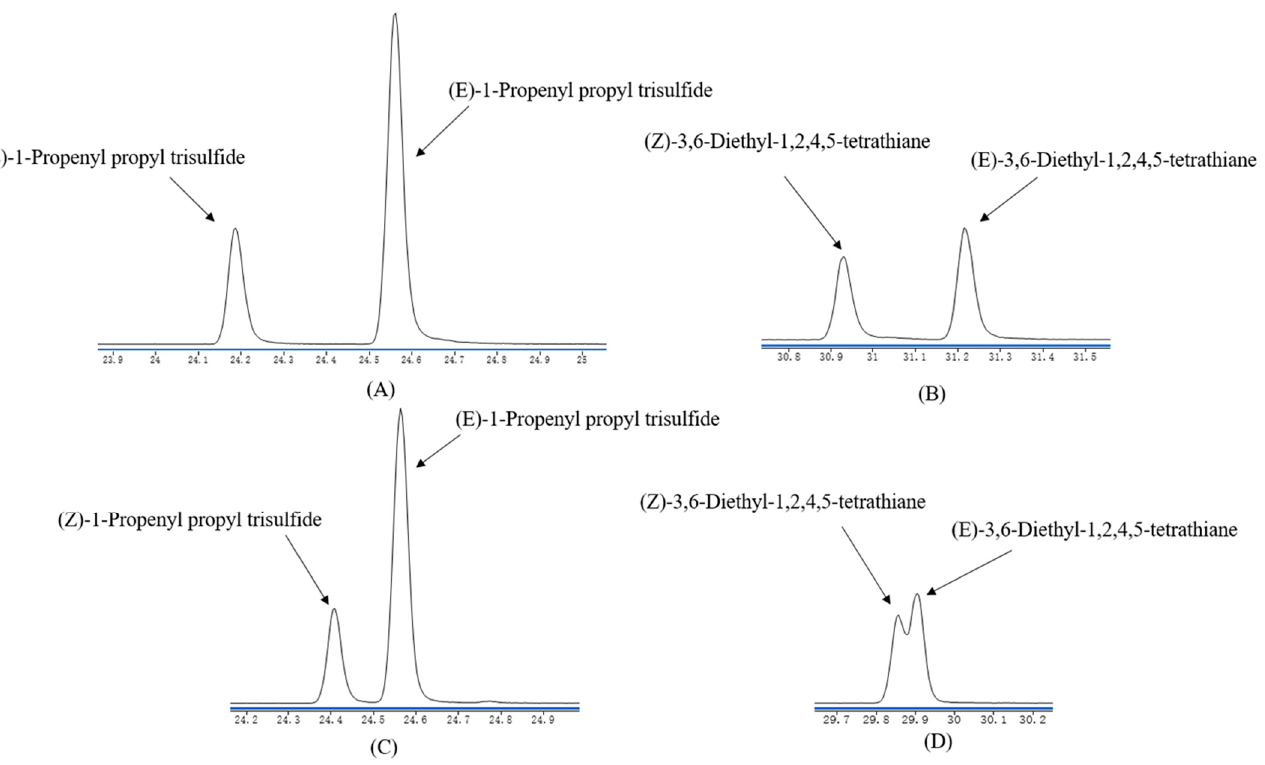
Figure 1. GC-MS signals of synthesized 43 , 44 , 46 , 47 by DB-WAX ( A , B ) and HP-5MS ( C , D ) column separation. Pyrazine, 2-pentylfuran, naphthalene, 2-naphthalene and two unknown compounds